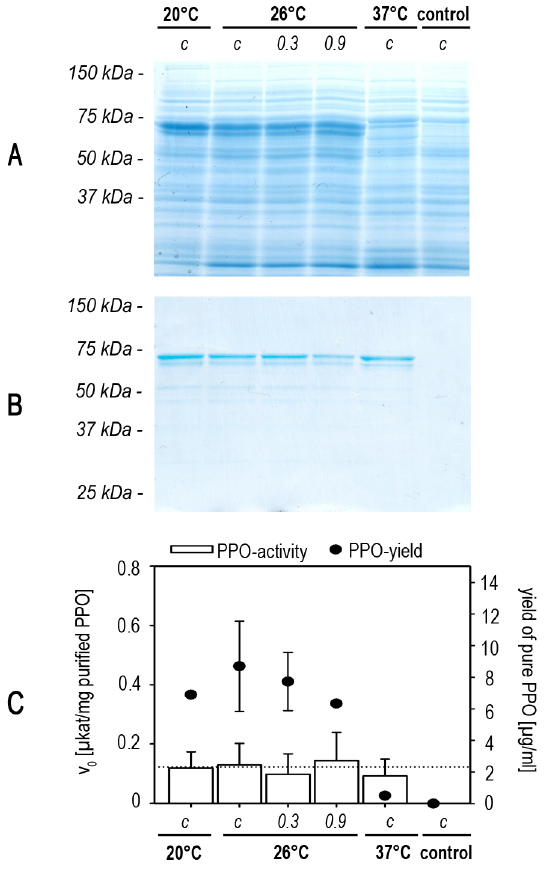
Figure 5. Optimal temperature for ToPPO-2 production. Production cultures were grown under different temperature settings. A SDS-PAGE of crude protein extracts. Samples were taken after 48 h and analyzed by SDS-PAGE (equal total protein amount per well). To visualize protein composition a Coomassie-staining was performed. B SDS-PAGE of purified proteins. ToPPO-2 was purified via affinity- chromatography using Strep-Tactin. Equal protein amounts were loaded on an acrylamide gel and analyzed by SDS-PAGE and Coomassie staining. C Protein yields and specific PPO-activity after purification. The specific PPO-activity (v 0 ) was analyzed per mg of purified PPO. The average value from all samples is given as a dotted line. Yields of purified protein per volume of bacterial culture were also calculated. c: continuous growth in given temperature; 0.3/0.9: growth at 37 u C until OD 600 nm of 0.3/0.9 was reached, then grown at 26 u C; control: empty vector control grown at 26 u C.